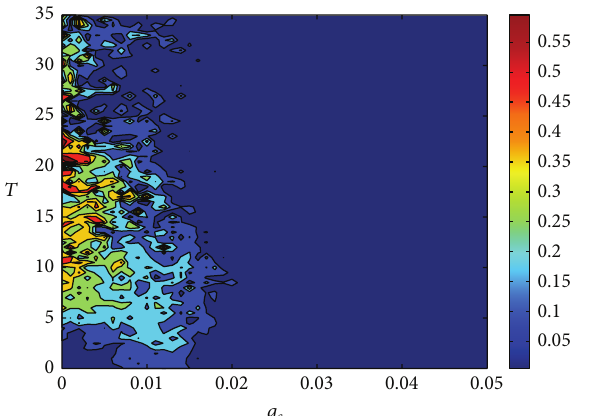
Figure 7: The contour plot of the ISI distance in the (𝑔 𝑐 , 𝑇) plane for ring-like network.